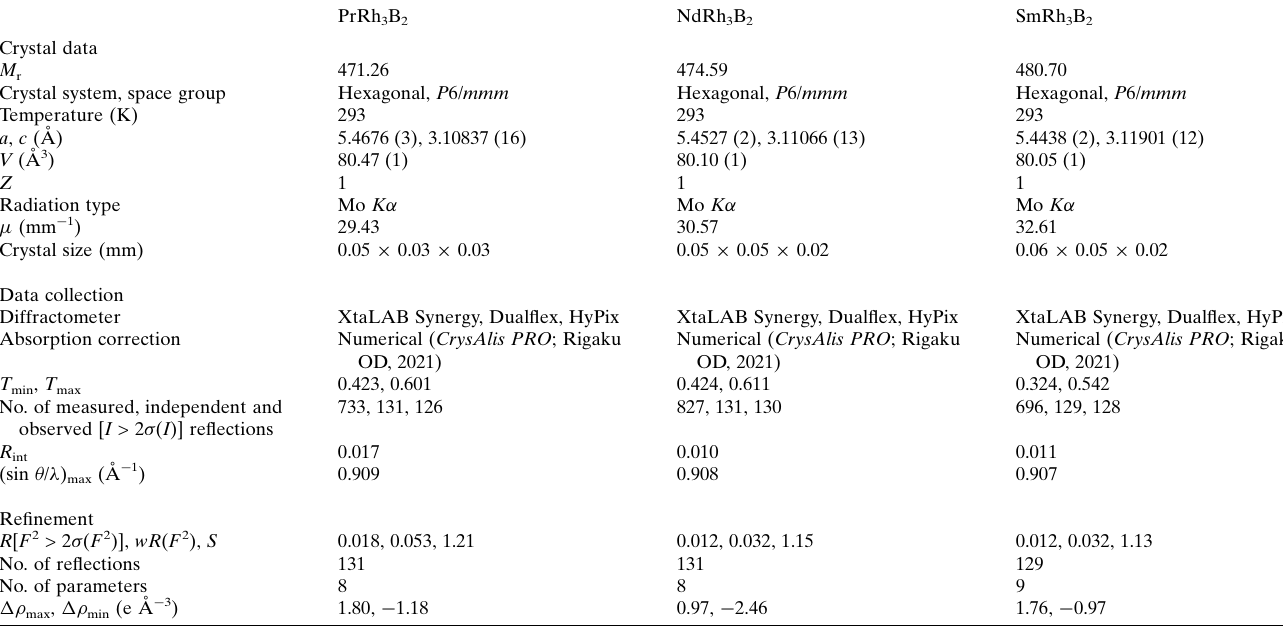
Table 3 Experimental